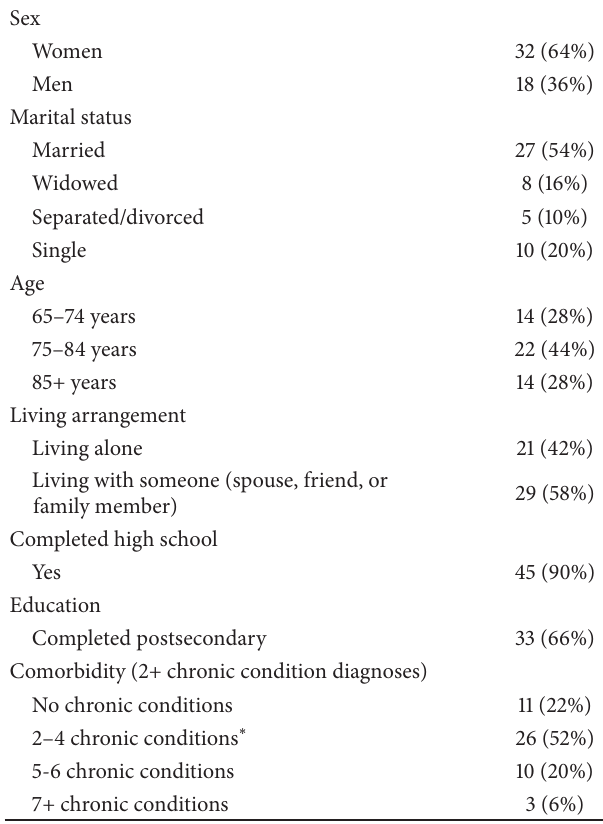
Table 1: Frequencies of participant demographics (𝑛 = 50)